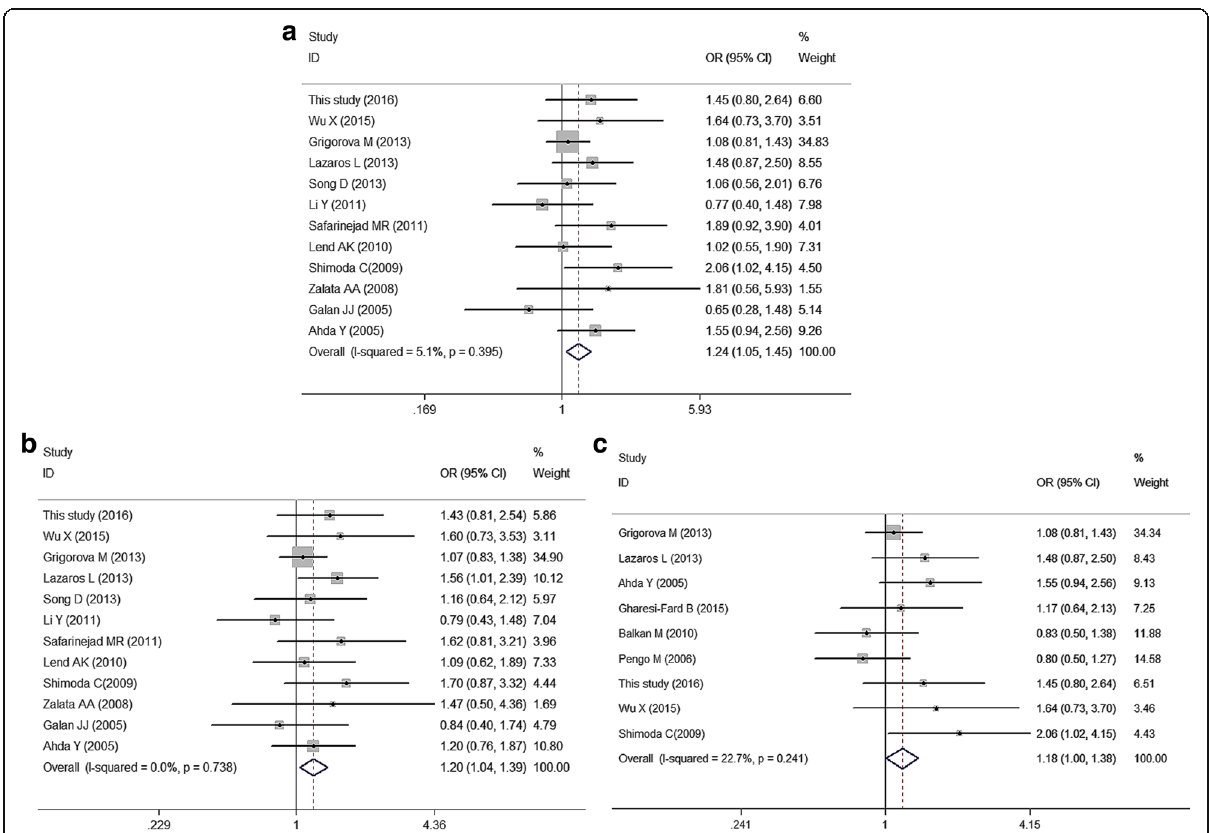
Fig. 3 Meta-analysis of male infertility risk associated with FSHR rs6166 for fixed effects model. a GG vs. AA in subgroup analysis of HWE > 0.05; ( b ) GG vs. AA + AG in subgroup analysis of HWE > 0.05; ( c ) GG vs. AA in subgroup analysis of case count >